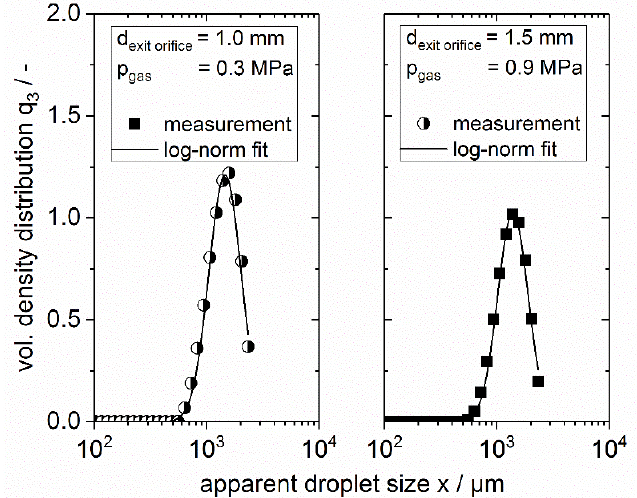
Figure 5. Volumetric density distribution q 3 of apparent droplet sizes (( left ) d exit orifice = 1.0 mm, p gas = 0.3 MPa; ( right ) d exit orifice = 1.5 mm, p gas = 0.9 MPa) and corresponding log-normal fits (R 2 > 0.99).